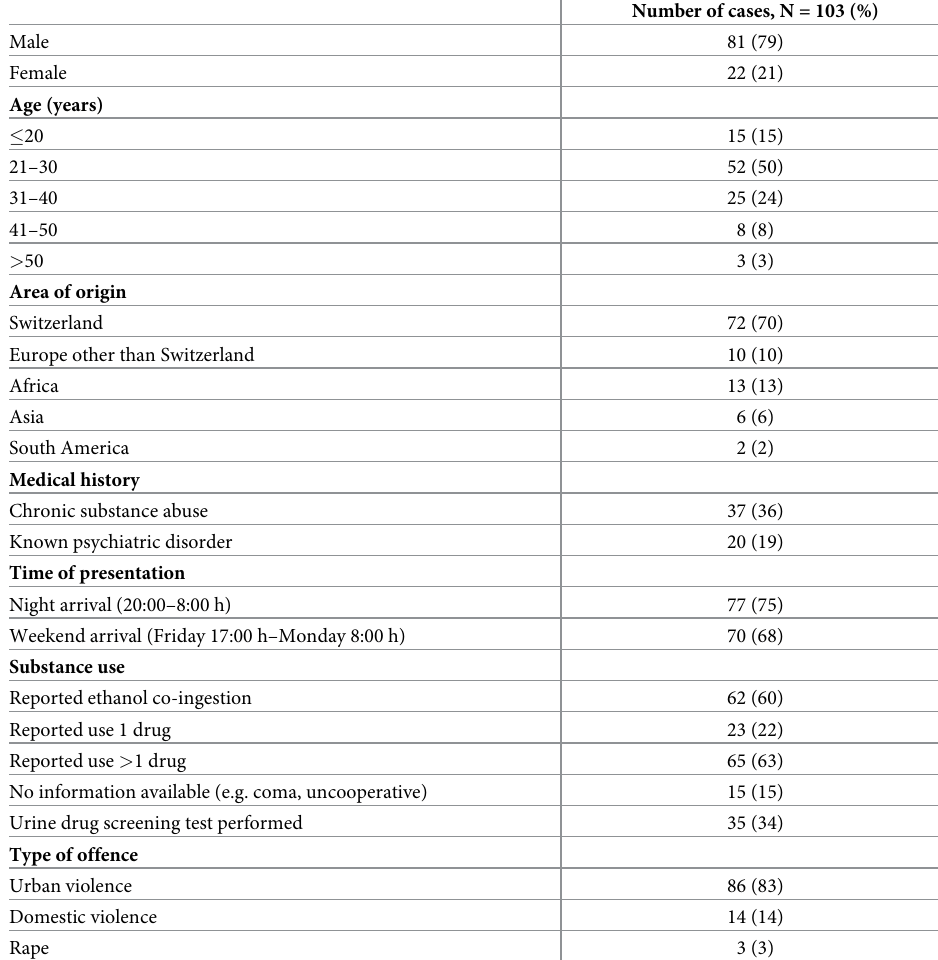
Table 1. Patient and case characteristics.